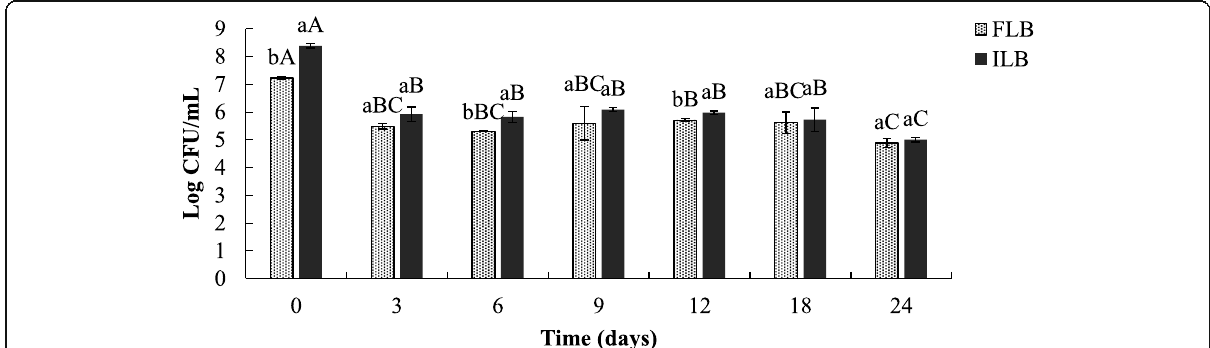
Fig. 6 Viability of FLB and ILB in ale beer during 24 days of storage at 21 °C. a-b Means with no letter in common between treatments within the same incubation time are significantly different ( P < 0.05). A-C Means with no letter in common within the same treatment across incubation times are significantly different ( P < 0.05). FLB = free Lactobacillus brevis and ILB = immobilized Lactobacillus